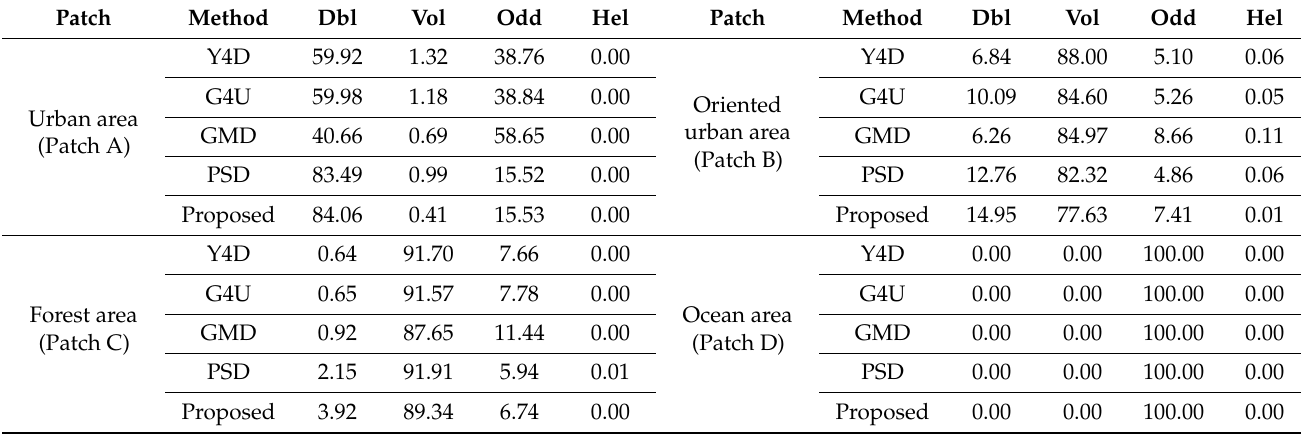
Figure 9. Decomposition results of patches (A, B, C) selected from spaceborne L-band ALOS-2 data. ( a1 – e1 ) are the de-composition results over urban area (A). ( a2 – e2 ) are the results of oriented urban area (B). ( a3 – e3 ) are the results of forests area (C). The images are colored by Pd ( red), Pv (green), and Ps (blue).